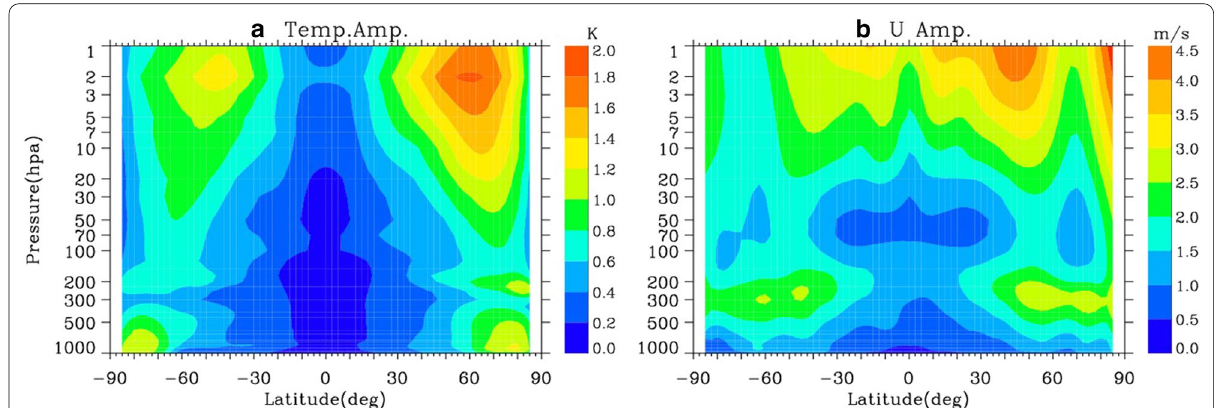
Fig. 3 Latitude-pressure distribution of the monthly mean Q16W1 amplitude in ( a ) temperature and ( b ) zonal wind averaged over 39 years from the ERA-Interim data